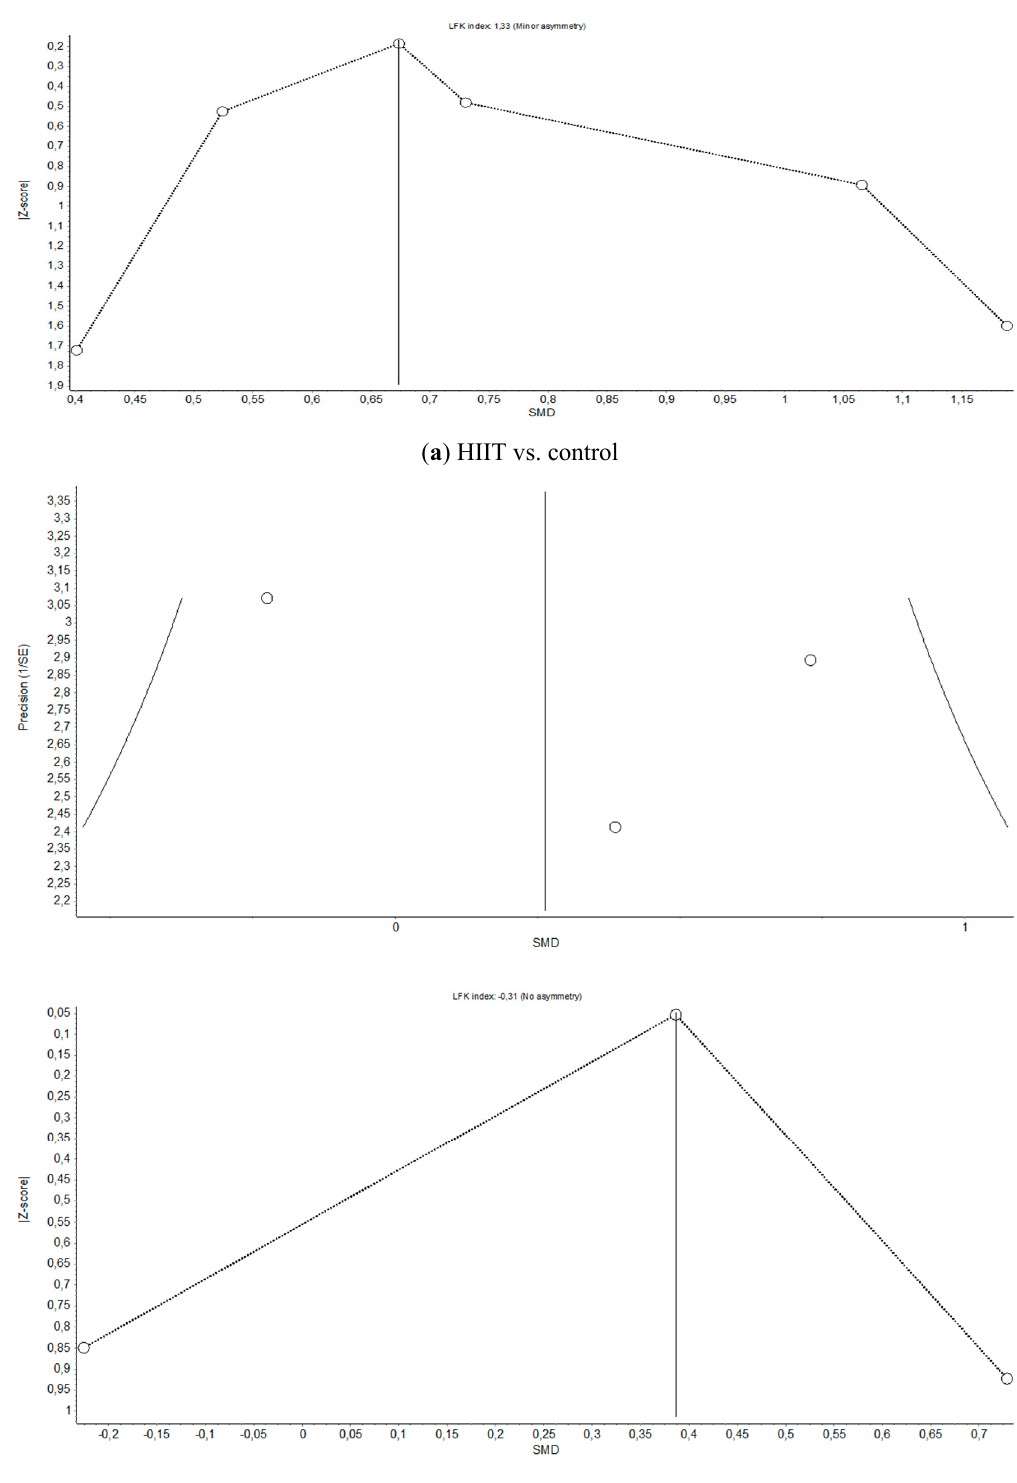
Figure A2. Synthesis funnel and Doi plot (LFK index) for VO 2 max to assess the presence of publication bias.